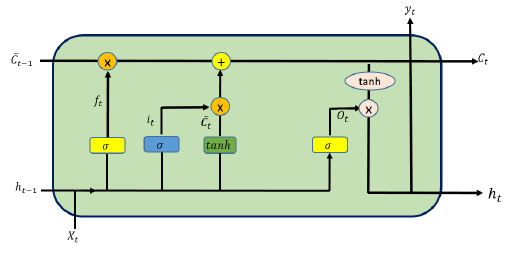
Figure 5. A typical structure of an LSTM Network.